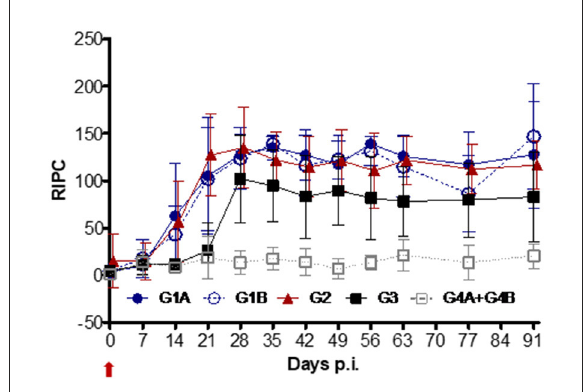
FIGURE6 Kinetics of anti- T. foetus IgA levels measured by ELISA in CVM. Immunized/challenged groups: Trichobovis via subcutaneous (SC; G1A) or intravulvar (IVU; G1B) routes, TrichGuard vaccine by SC route (G2). Non-immunized/challenged (G3) and non-immunized/non-challenged (G4A + G4B) groups. All challenged cows were inoculated intravaginally with 2 × 10 6 T. foetus trophozoites and non-challenged cows with PBS. The average IgA levels measured throughout the experimental time (X-axis; days p.i.) are represented in the graph using the relative index percent (RIPC) value (Y-axis). Error bars represent the standard deviation. Day 0 is the day of the challenge (red arrow).